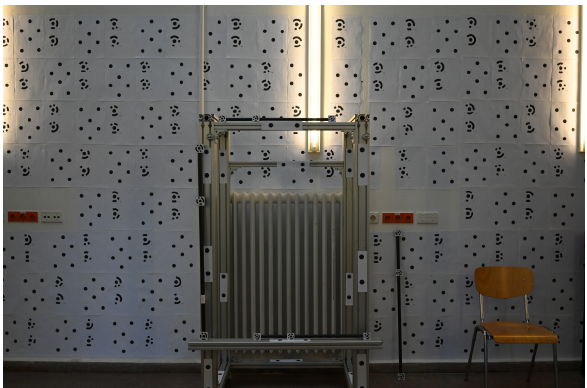
Figure 5. The format filling test field for camera calibration at the Institute of Photogrammetry and Remote Sensing, TU